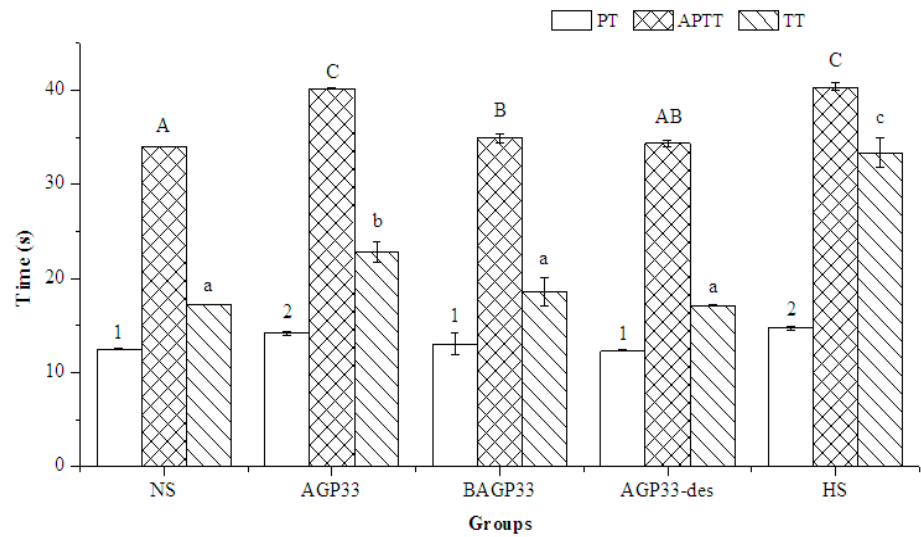
Figure 7. The anticoagulant activity of AGP33 compared with AGP33-des and BAGP33 at concentration of 50 μ g/mL. NS means normal saline group. HS was a positive control with concentration of 0.5 μ g/mL. Results are presented as means ± standard deviations ( n = 3). Significant differences between different groups were evaluated by One-Way ANOVA ( post hoc test: S-N-K). Values in the same dose of different groups with different numbers (1–2), lower case letters (a–c) and capital letters (A–C) are significantly different at p < 0.05 .